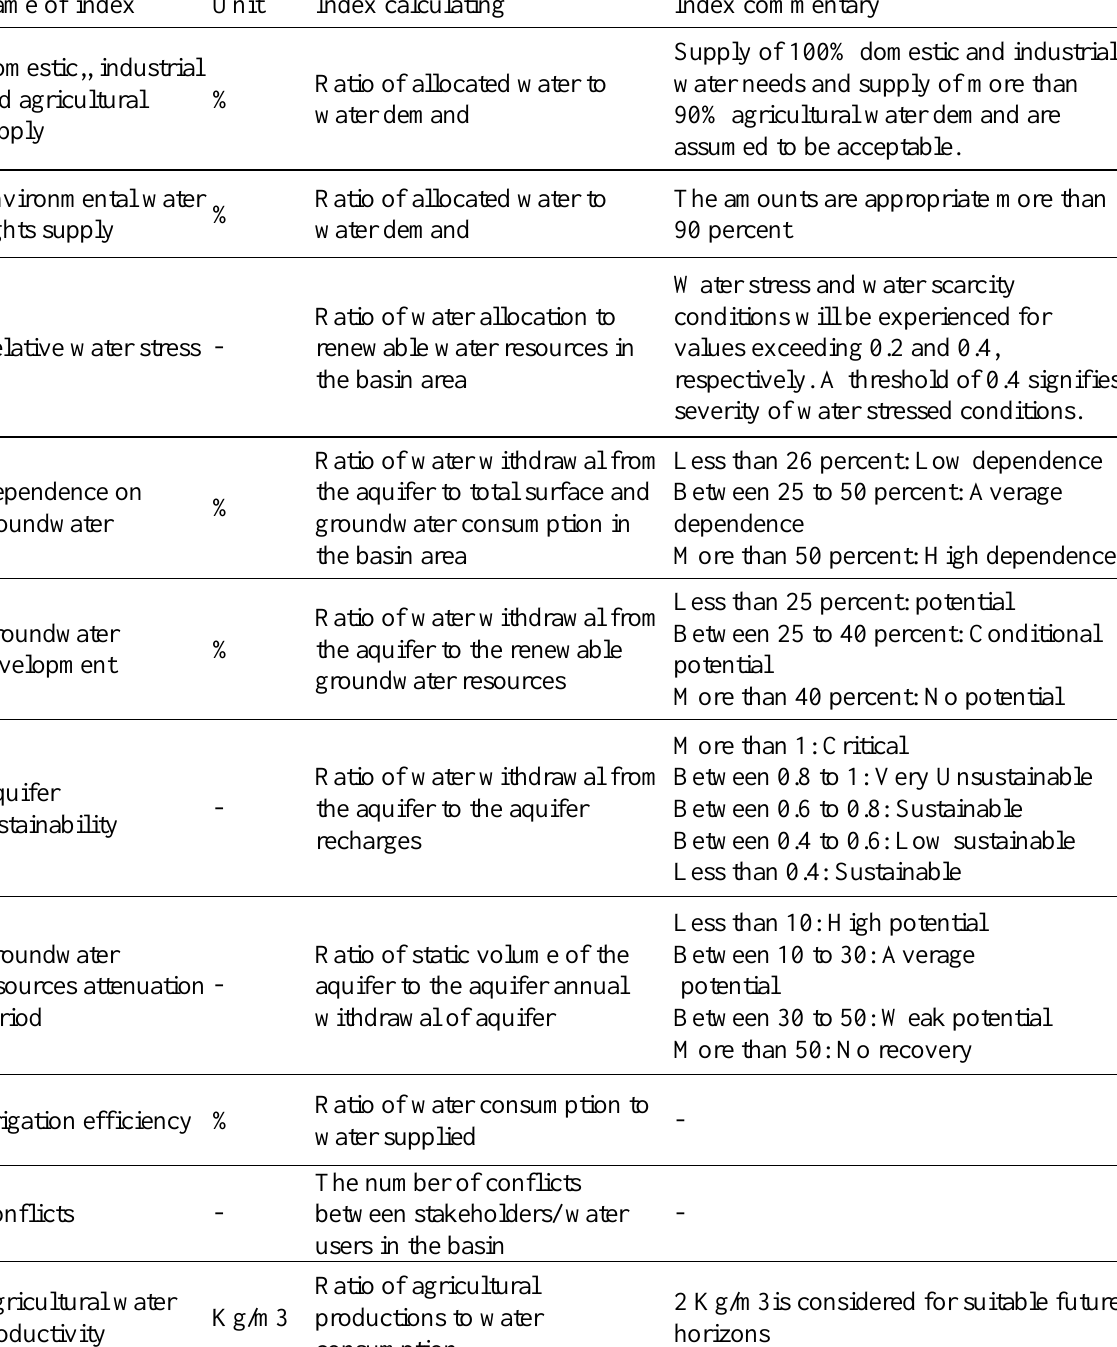
Table 1. Selected indices for evaluating different